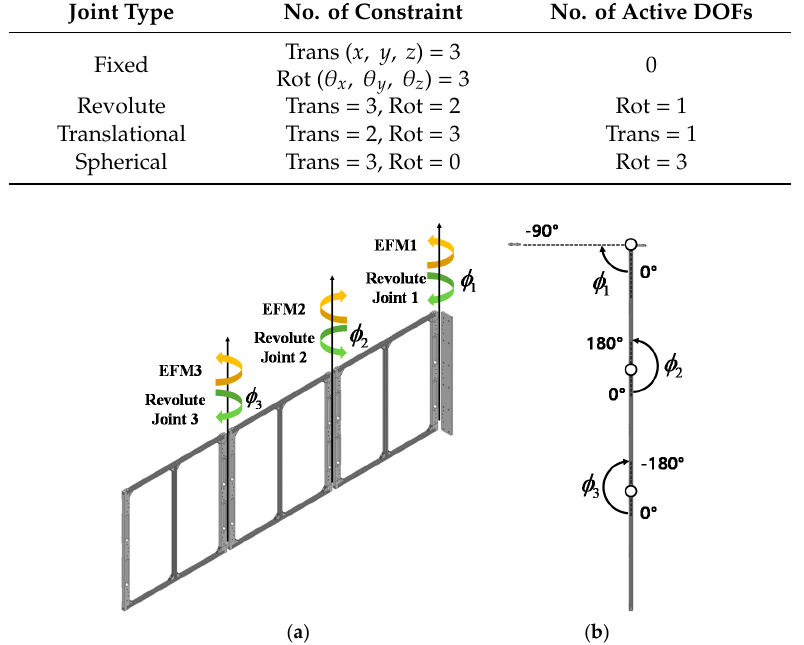
Figure 8. Configuration of the MBD modeling at the deployed configuration: ( a ) isometric view ( b ) top view.